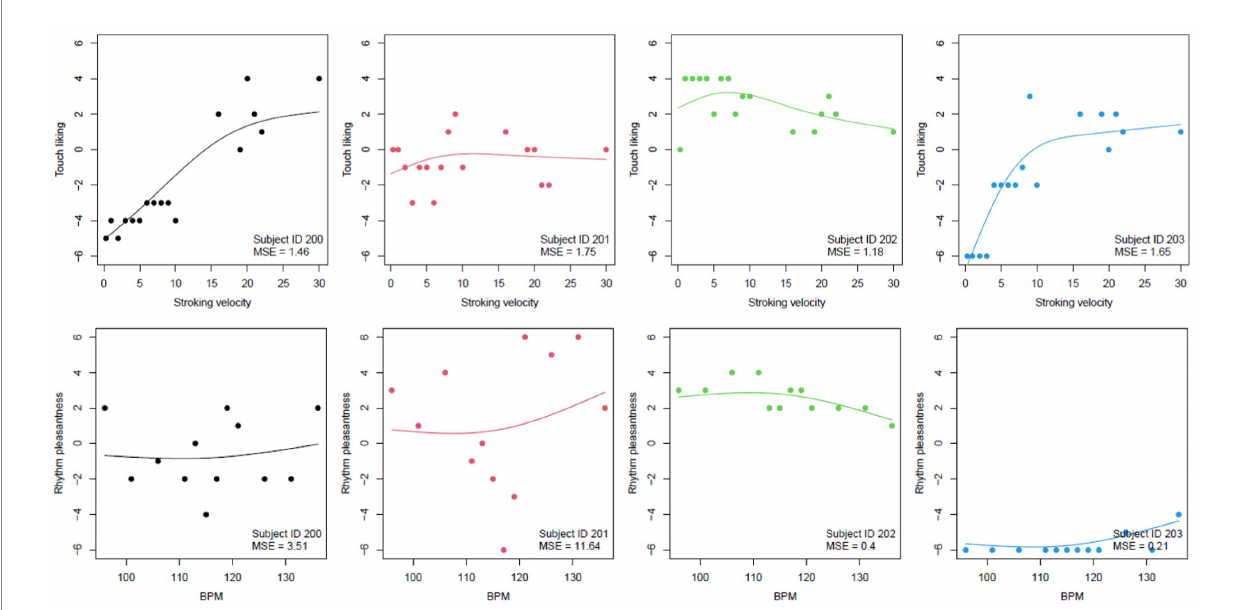
FIGURE 11 Touch (upper) and beat rating patterns (lower) with fit line for four participants. MSE = mean of the squared residuals as a measure of the goodness of the